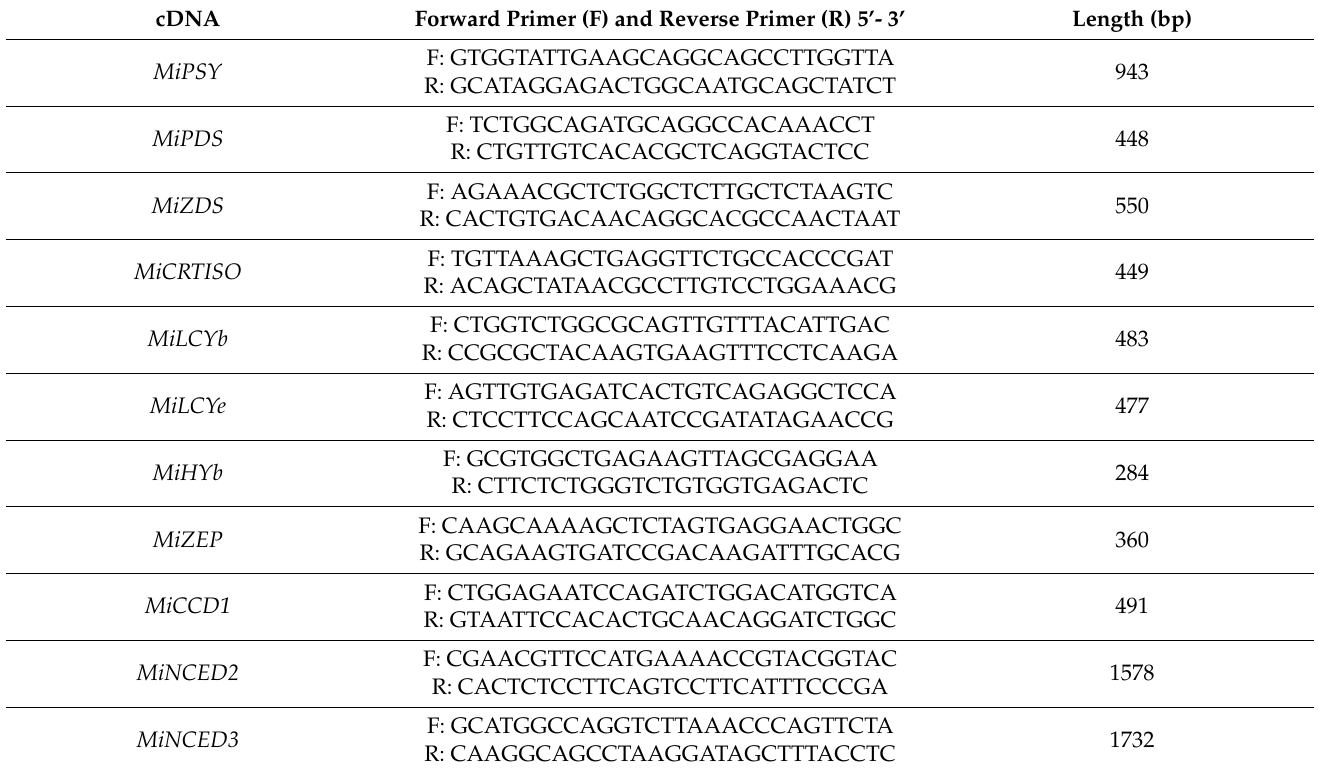
Table 1. Primers used for RT-PCR and cDNA lengths of genes involved in carotenoid metabolism pathway.